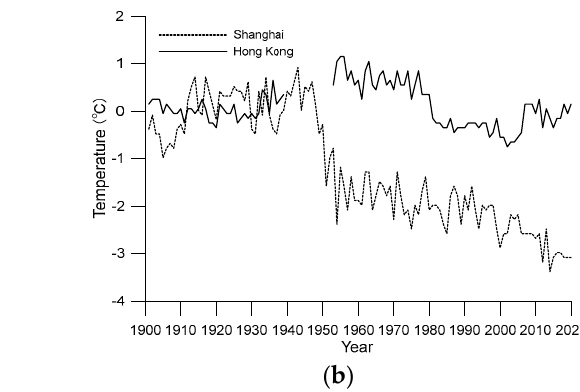
Figure 4. Annual average diurnal temperature range from 1901 to 2020 for the Shanghai and Hong Kong observatories (( a ) original observations; ( b ) anomalies to the average values during 1901–1930).